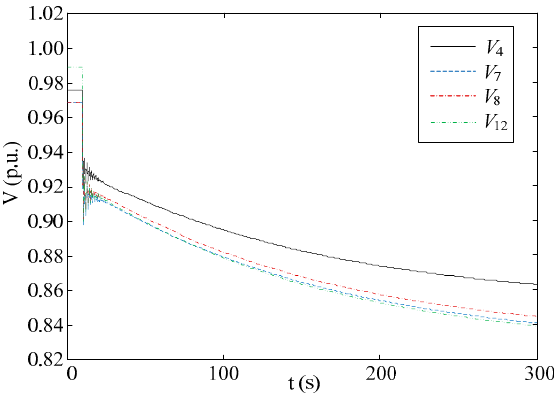
Figure 11. Voltage evolution without control in case B.